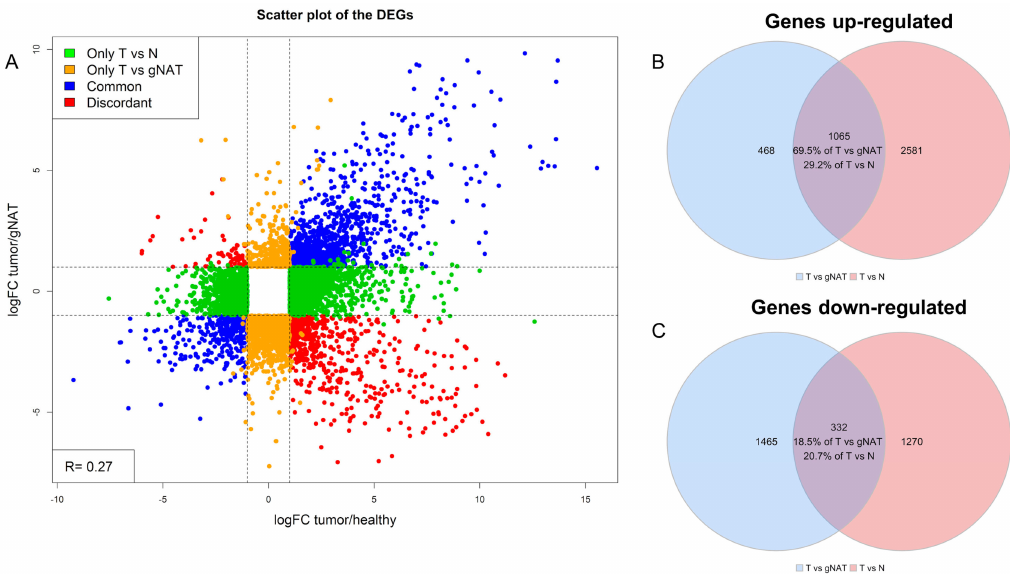
Figure 2. Tumor (T) vs. gNAT and T vs. normal di ff erentially expressed genes. ( A ) Scatter plot of the log 2 FC. DEGs in green exclusively in T vs. N, in orange exclusively in T vs. gNAT, in blue in common while in red discordant. ( B ) Overlap of the up regulated genes. ( C ) Overlap of the down-regulated